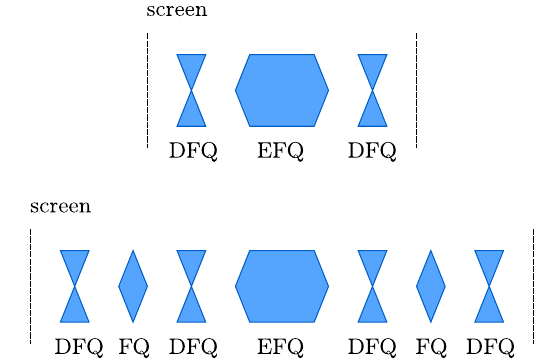
FIG. 9. Top: Simple lattice with one extended focusing quadru- pole (EFQ) treated with STGFM and two defocusing kick quads (DFQ) which together have the same absolute strength as the extended quad. Bottom: Extended quadrupole with additional focusing and defocusing quads. The same scaling factor is applied to all elements for adjusting the tune close to